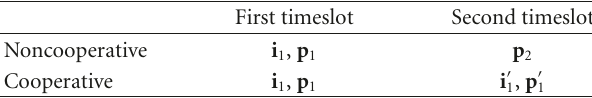
Table 1: Type of data sent during each timeslot. First timeslot